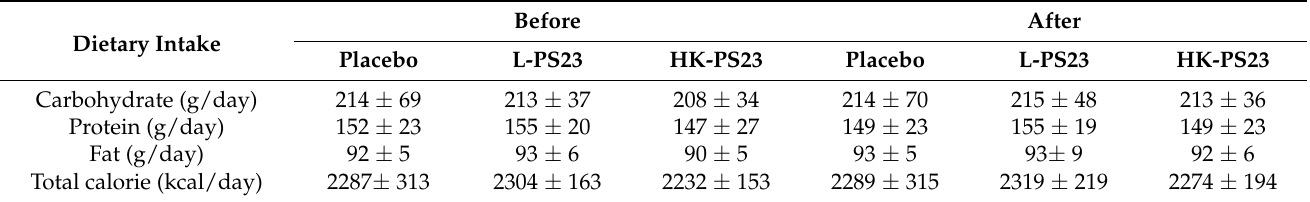
Table 2. Subject’s dietary intake before and after the 6-week L-PS23 and HK-PS23 intervention.